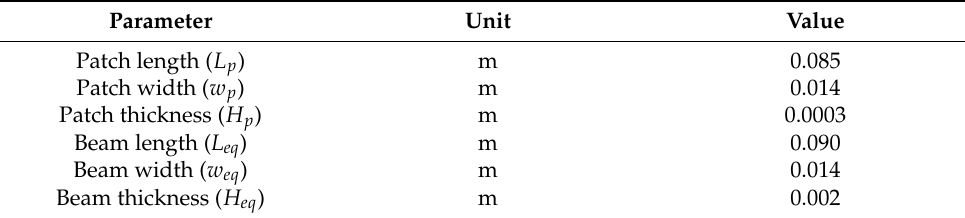
Table 4. Geometrical features of the FE